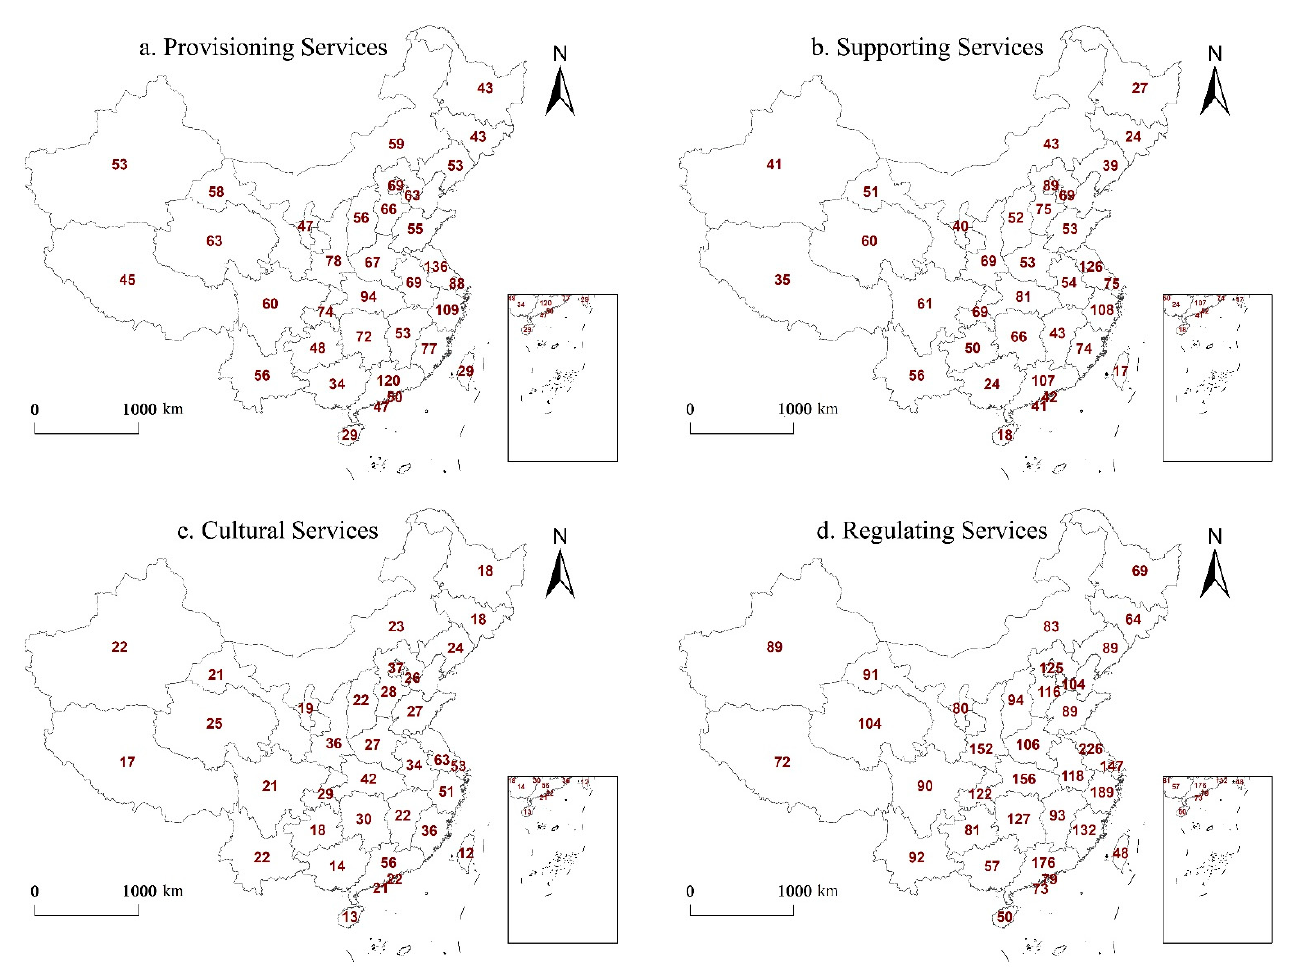
Figure 7. Distribution of studies on different types of ecosystem service. The numbers in the figure are the number of different ecosystem services studies in each region.